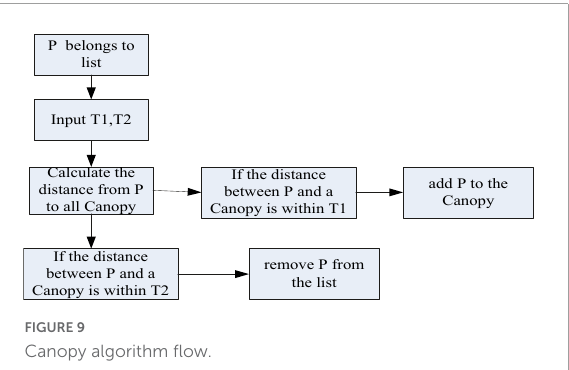
FIGURE9 Canopy algorithm